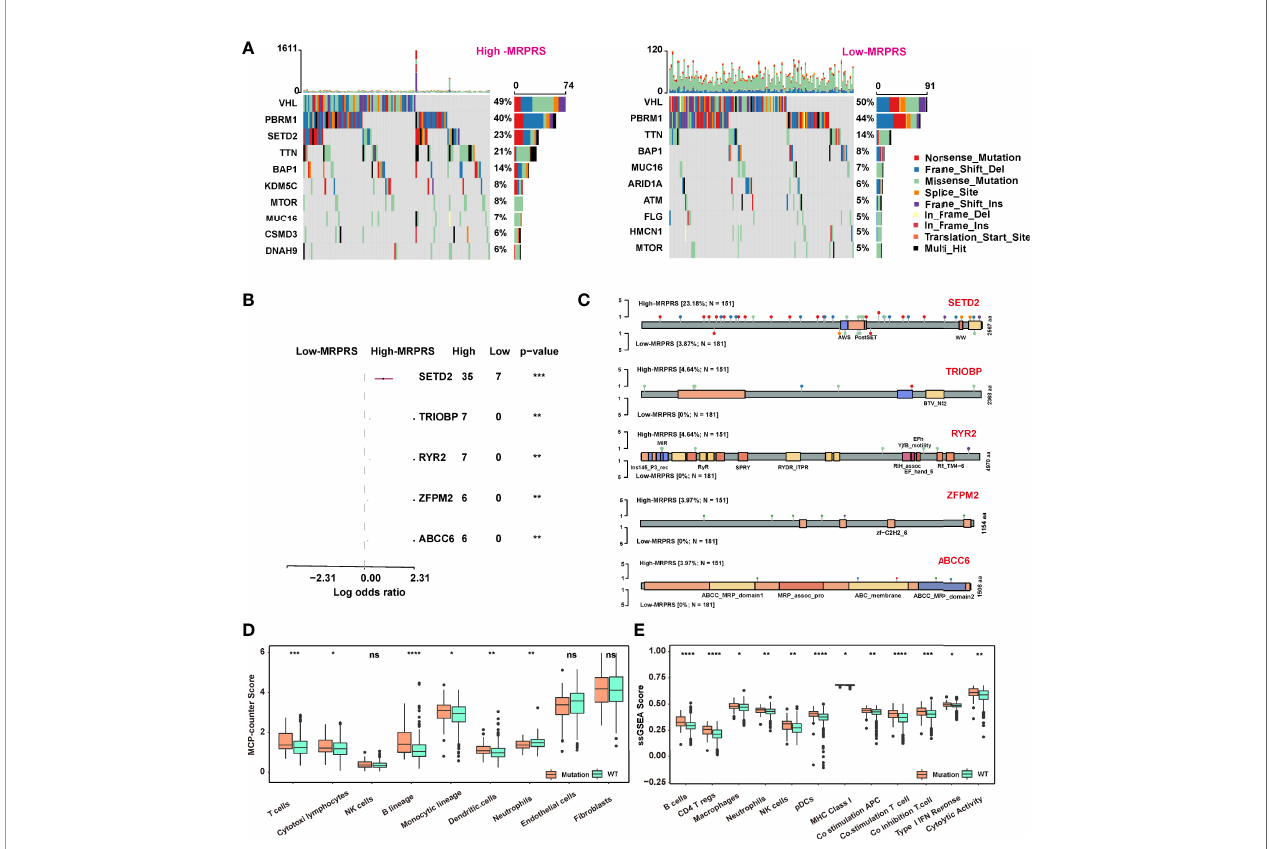
FIGURE 4 | (A) Waterfall plot of the distribution of mutations found in the high- and low-MRPRS groups of the TCGA-ccRCC cohort. (B) The top 5 genes of high- vs. low-MRPRS group mutation status. (C) Lollipop plot of somatic mutations in SETD2, TRIOBP, RYR2, ZFPM2, and ABCC6. (D, E) MCP_counter and ssGSEA algorithm were used to estimate the abundance of various types of immune cells in high- and low-MRPRS groups (*p < 0.05; **p < 0.01; ***p < 0.001; ****p < 0.0001; ns, not signi fi